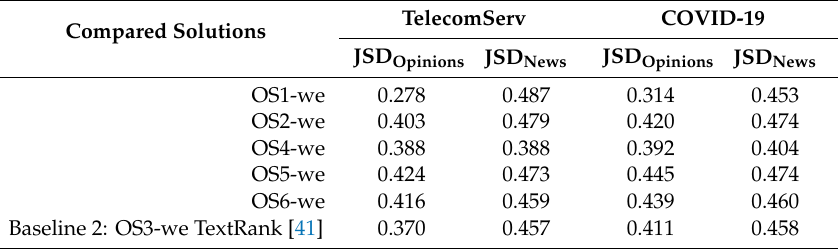
Table 4. Summary of averaged results of the JSD News and JSD Opinions metrics considering word-embedding-based semantic processing.